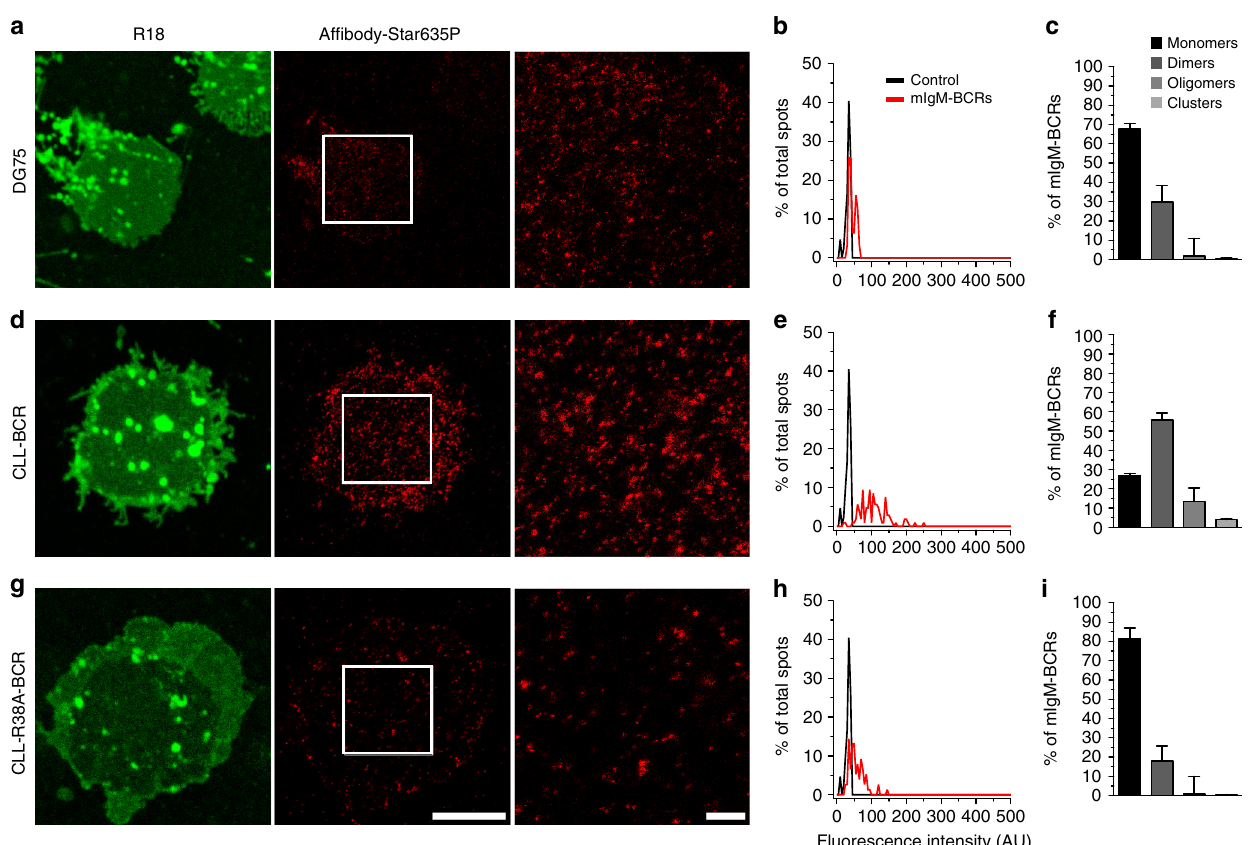
Fig. 3 Cell surface arrangement of a CLL-derived mIgM-BCR. a , d , g Plasma membrane sheets of DG75 B cells ( a ), an mIgM neg variant expressing a CLL- derived mIgM-BCR (CLL-BCR, d ) or the R38A-mutant variant thereof (CLL-R38A-BCR, g ) were analyzed as in Fig. 1. White squares indicate the zoomed regions. Scale bars represent 5 µ m for the low zoom images and 1 µ m for the high zoom STED images. b , e , h Example histograms of the spot fl uorescence intensities for each cell type. c , f , i Percentages of different mIgM-BCR arrangements were derived as in Fig. 1. Data were obtained from three independent experiments including 16 membranes for DG75, 17 membranes for the CLL-BCR, and 12 membranes for the CLL-R38A-BCR (raw data in Supplementary Fig. 5). Error bars represent the 68% con fi dence interval, corresponding to 1 standard deviation. Histogram ’ s source data are provided as a Source Data fi